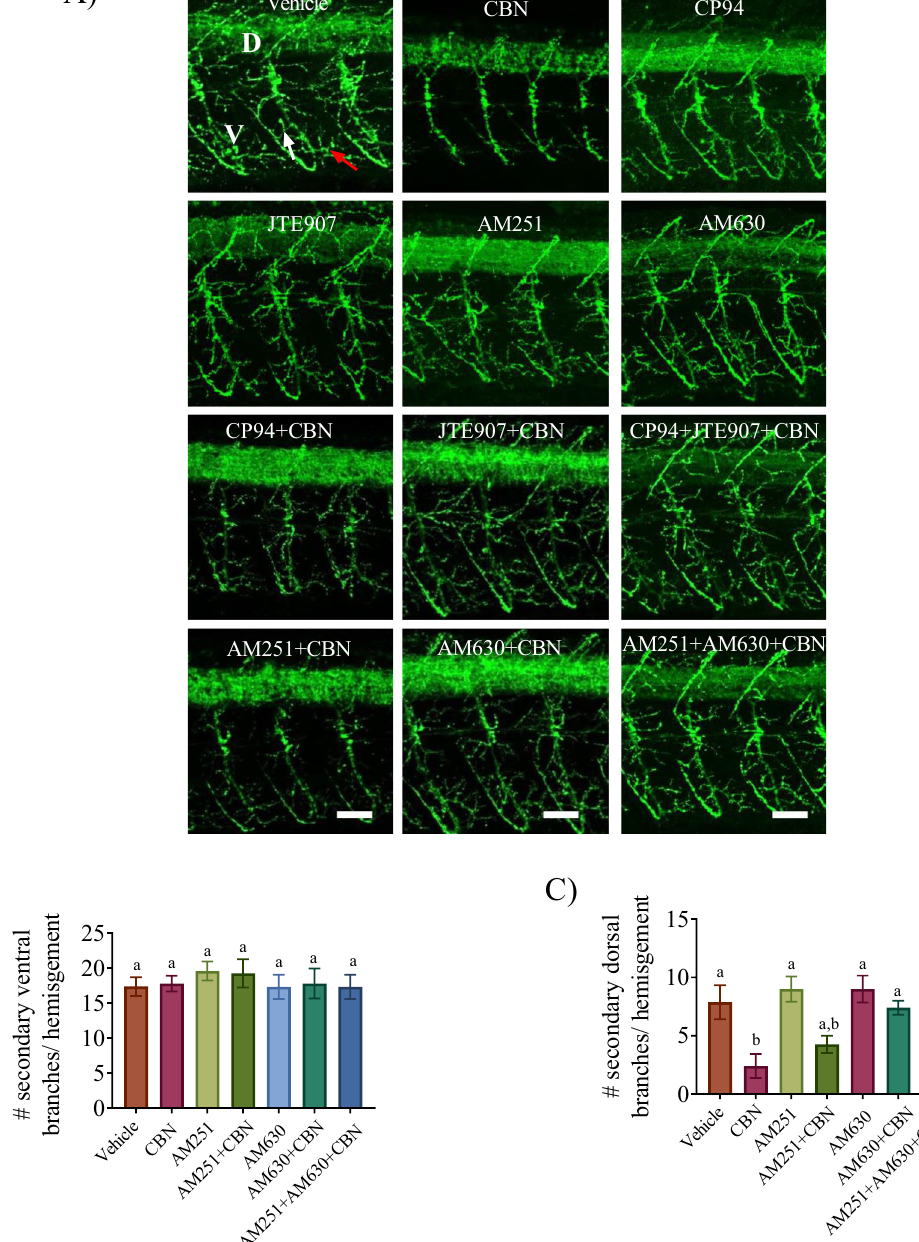
Figure 4. Combined exposure of Cb2r and CBN inhibits CBN-induced changes in primary motor neuron branching. ( A ) Znp-1 (green) antibody was used to label primary motor neuron axons and their branches in vehicle control (n = 7), 3 mg L −1 CBN (n = 9), AM251 10 nm + 3 mg L −1 CBN (n = 8), CP94 10 nm + 3 mg L −1 CBN (n = 9), AM630 10 µm + 3 mg L −1 CBN (n = 9), JTE907 10 µm + 3 mg L −1 CBN (n = 8), AM251 10 nm + AM630 10 µm + 3 mg L −1 CBN (n = 5) and Cp94 10 nm + JTE907 10 µm + 3 mg L −1 CBN (n = 6). Dorsal and ventral branches in a motor axon are indicated with (D) and (V) respectively, and the white arrow points to secondary branches in the vehicle image. N = 3 experiments; Scale bar represents 25 µm. ( B , C ) Bar graph shows the number of secondary branches in the dorsal and ventral regions of the trunk. N = 3 experiments. Groups which share the same letter(s) of the alphabet are not statistically different from one another; p <